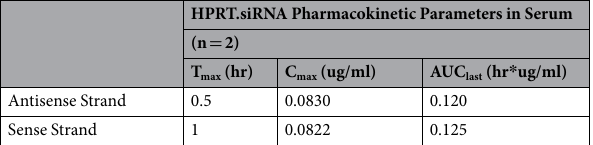
Table 3. Pharmacokinetic parameters of HPRT.siRNA antisense and sense strands in C57BL/6 mouse serum shown as Mean (SD). T max = time of maximum concentration; AUC last = area under the concentration time- curve from time 0 to last measurable concentration. All values are reported to 3 significant digits, with the exception of T max , which is reported as median